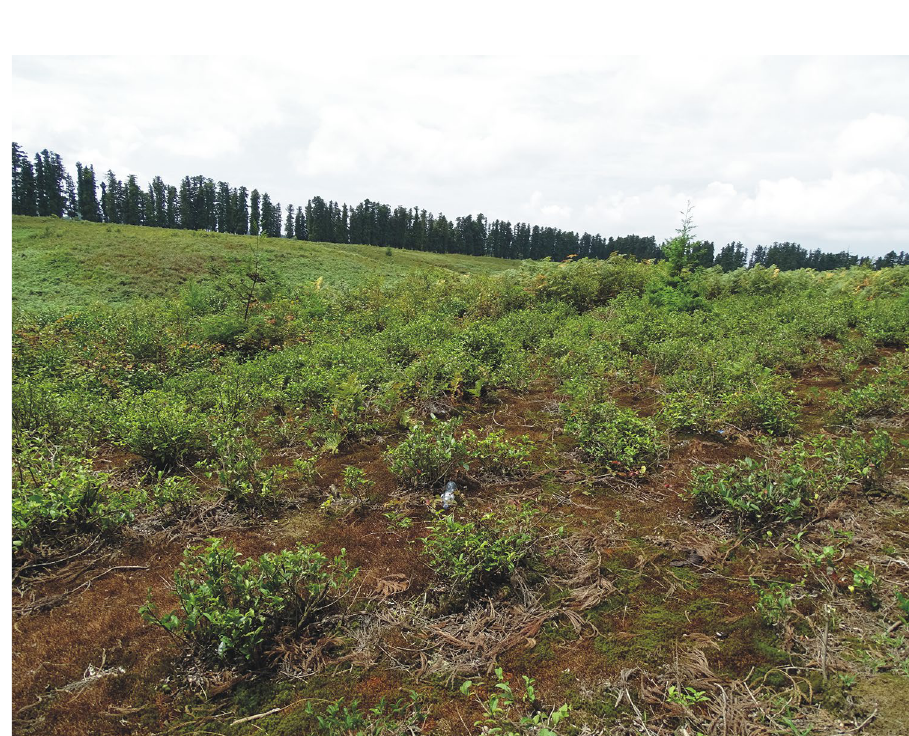
Figure 3. Uniform turfs formed by Polytrichum on the soil around tea bushes on the plantation in Ozurgeti (photo by R. Piwowarczyk, 29 July